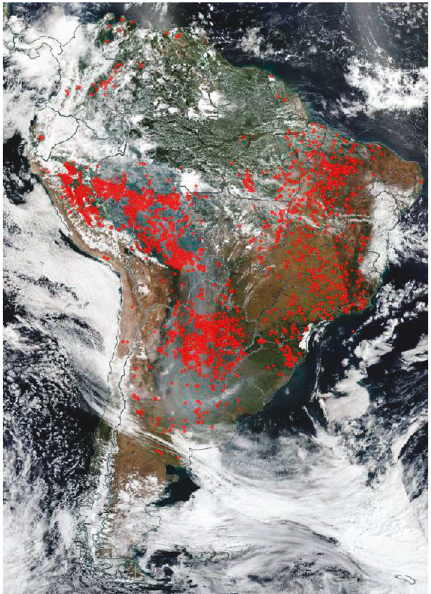
Figure 1: Smoke plume and fire spots on 26 August 2016 (available at